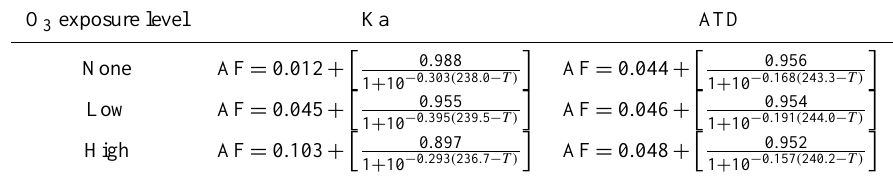
Table 4. Fits for immersion mode ice-active fraction as a function of temperature (K) as shown in Fig.